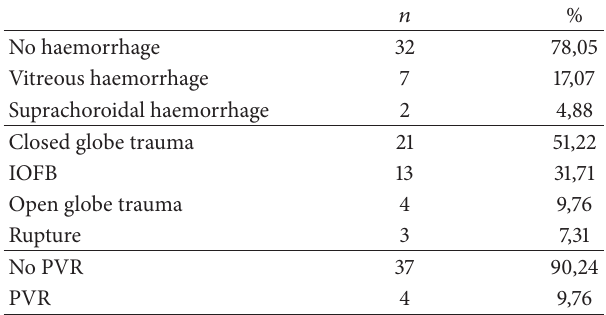
Table 1: Preoperative data of patients (type of trauma, presence of haemorrhage, and proliferative vitreoretinopathy (PVR), and intraocular foreign body (IOFB)).